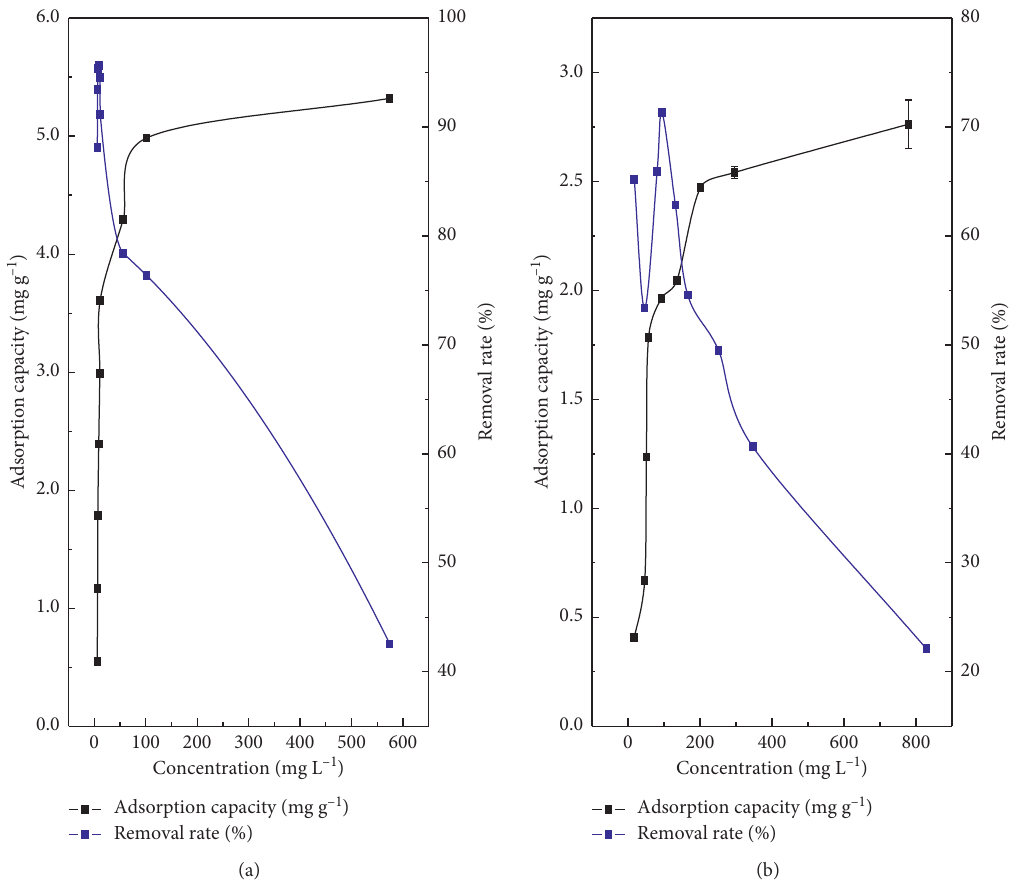
Figure 6: Effect of initial ion concentration on the adsorption of wastewater (a) Cu (II) and (b) Cd (II) by SACL (experimental condition: contact time � 180min; amount of adsorbent � 4g; pH � 4; temperature � 25 ° C; and agitation speed � 150rpm) (error bars represent the standard deviation of three